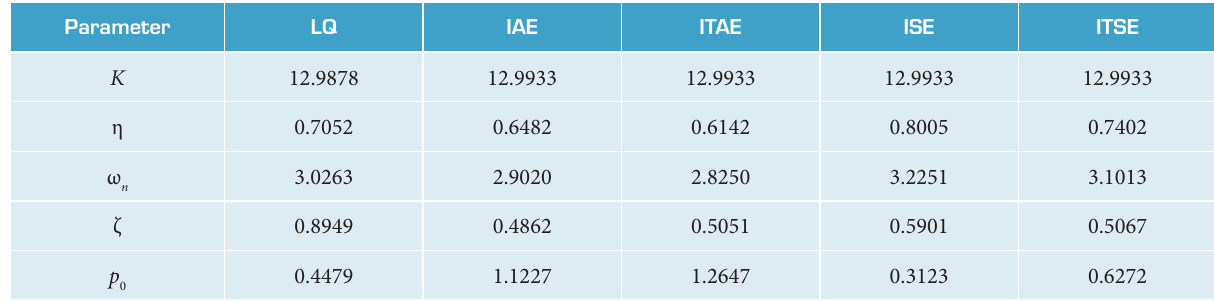
Table 2. Calculated reference